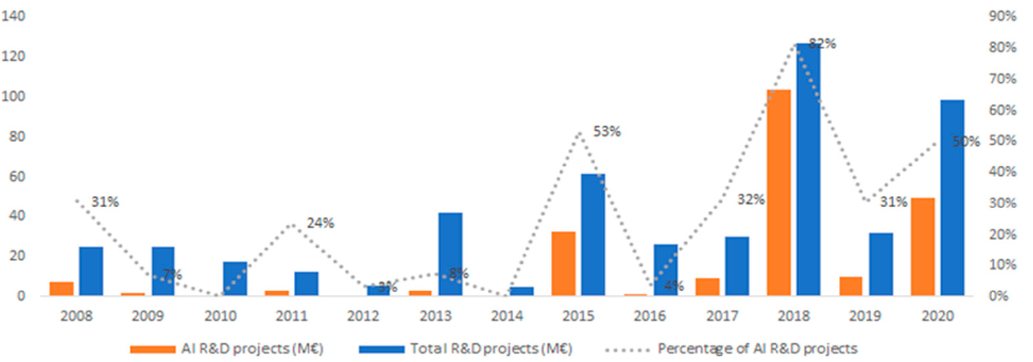
Figure 2. Variation of R&D project investments in the automotive sector from 2008 to 2020. (Source: author’s calculations from Portugal’s R&D project database).